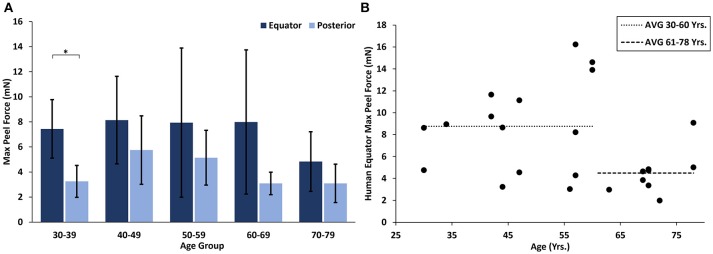
(A) Maximum peel force for human specimens by age group and region. Error bars indicate standard deviation from the mean (*p < 0.03). (B) Equatorial maximum peel force was significantly reduced after 60 years of age (p < 0.01). Bars indicate mean data prior to and including 60 years of age, and after 60 years of age.